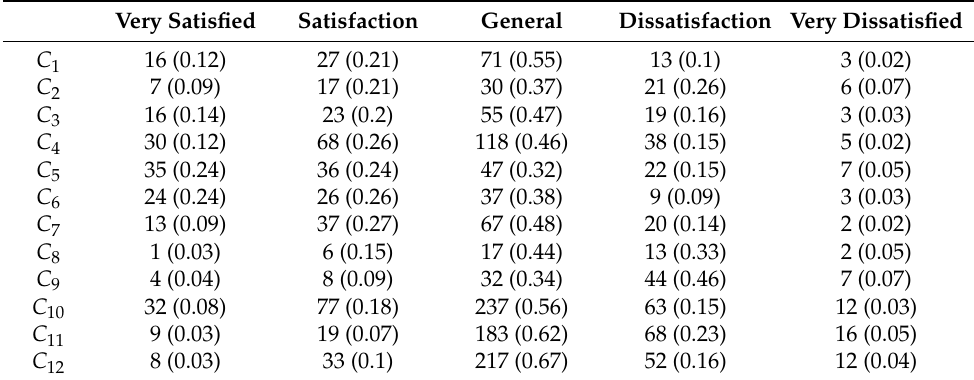
Table 5. User satisfaction level affiliation for mobile medical apps.